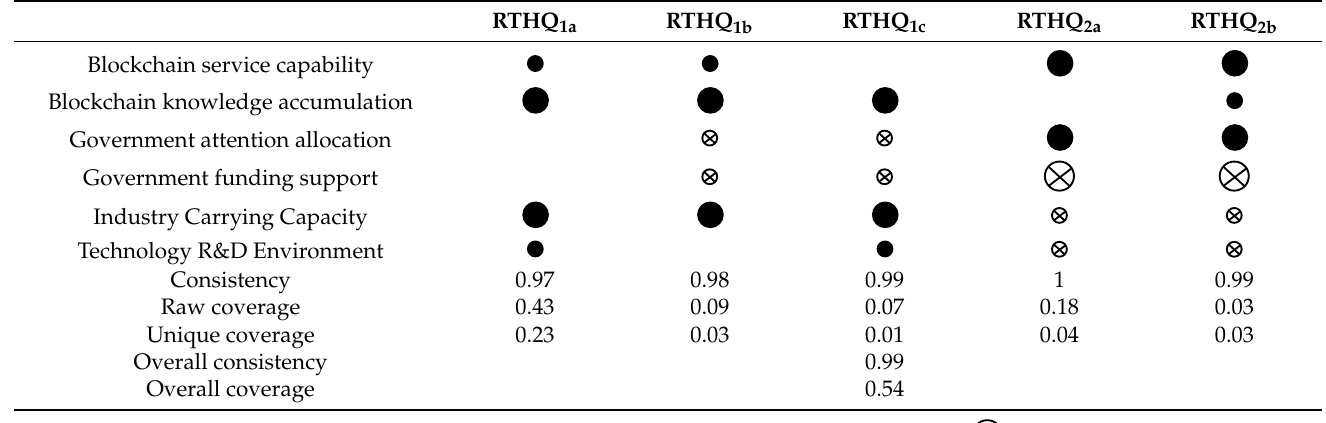
Table 8. Results of the robustness test with alternative crossover points.